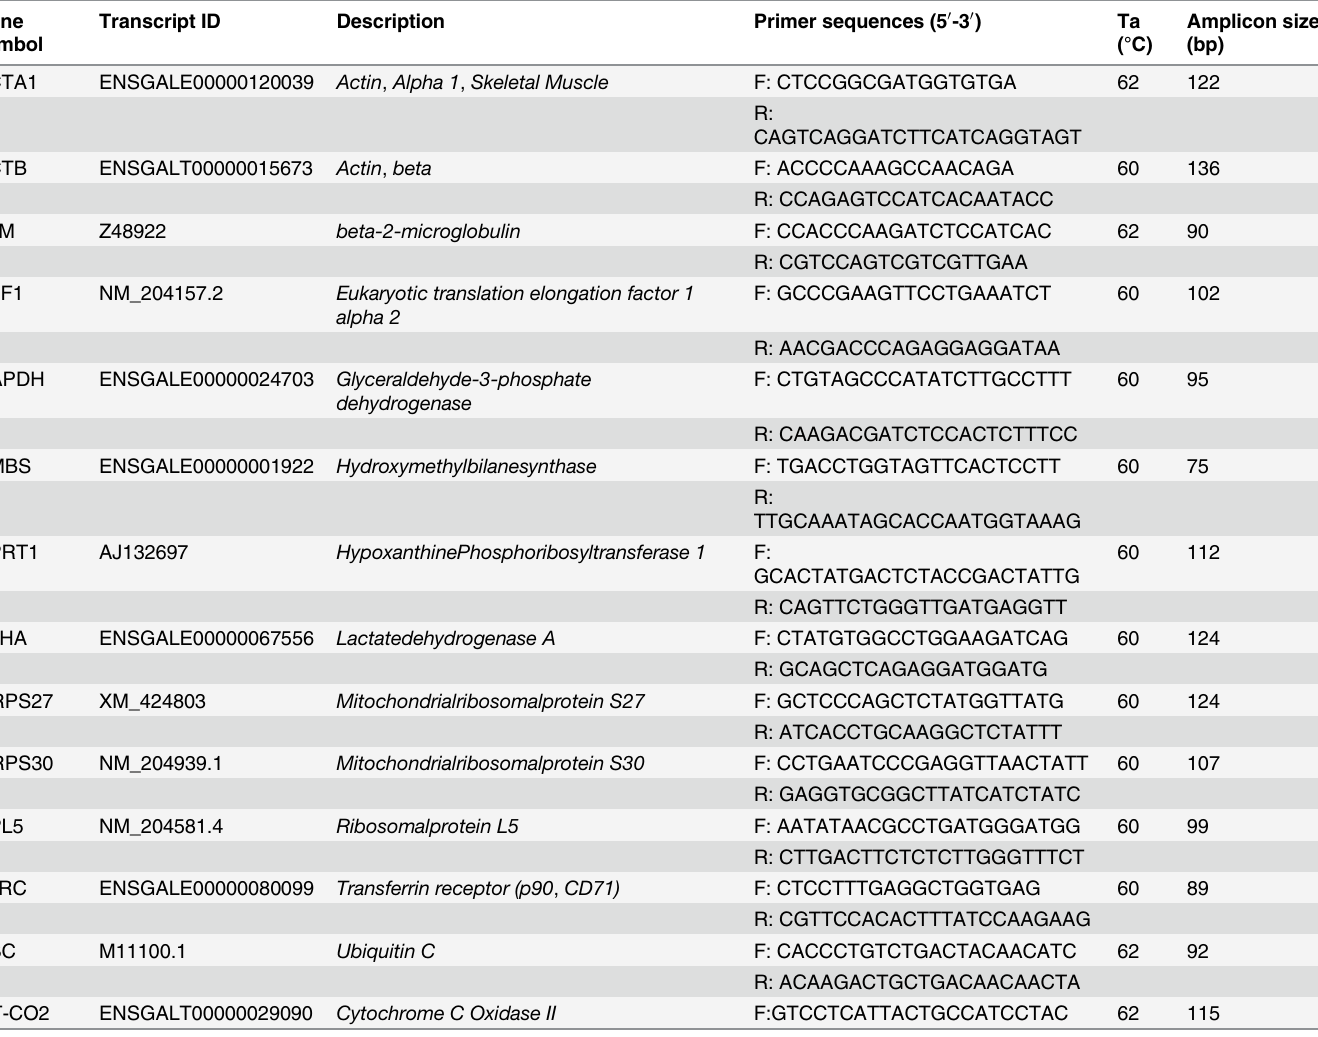
Table 1. Reference genes, MT-CO2 target gene, specific RT-qPCR primers and different parameters derived from RT-qPCR